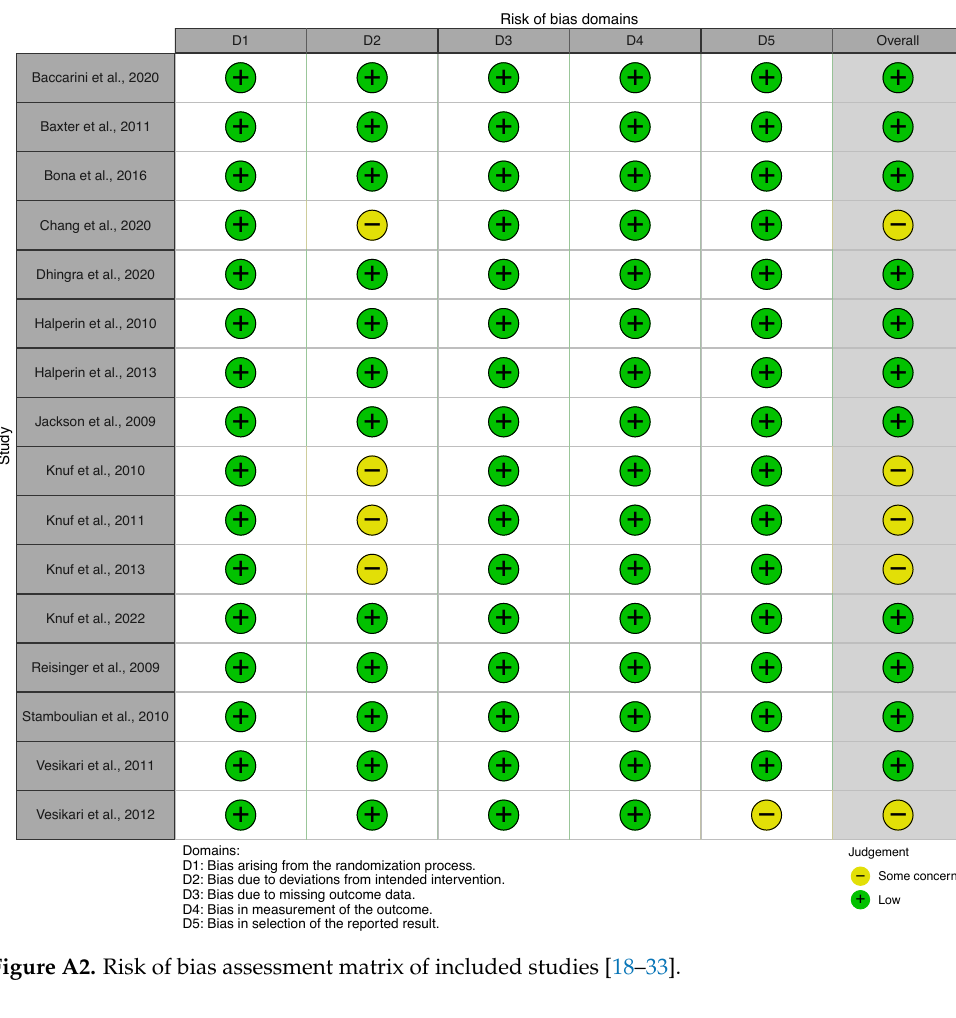
Figure A2. Risk of bias assessment matrix of included studies [18–33].